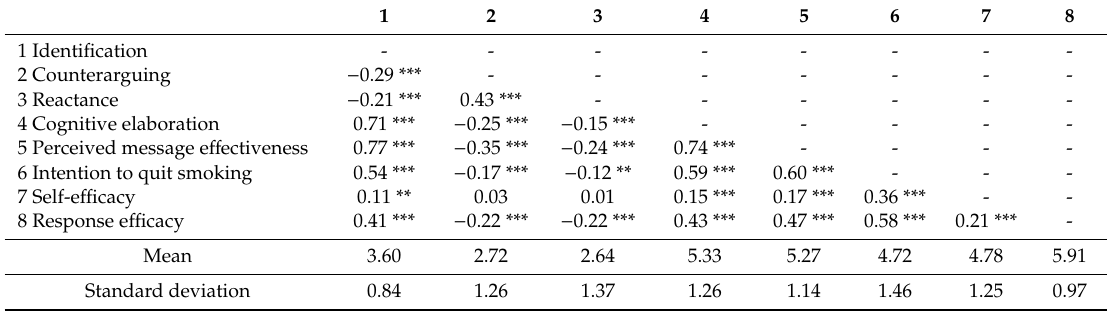
Table 3. Descriptive analysis and correlations between mediating and dependent